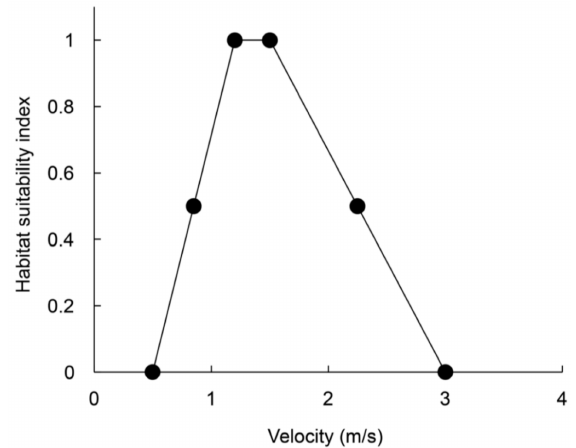
Figure 11. Coupled velocity suitability index curve.